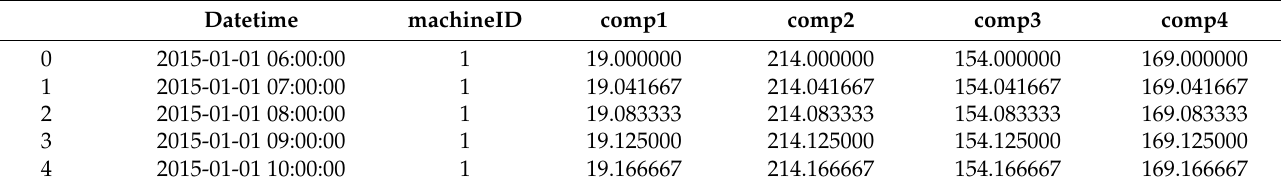
Table 10. Time since the last replacement, by type of component.